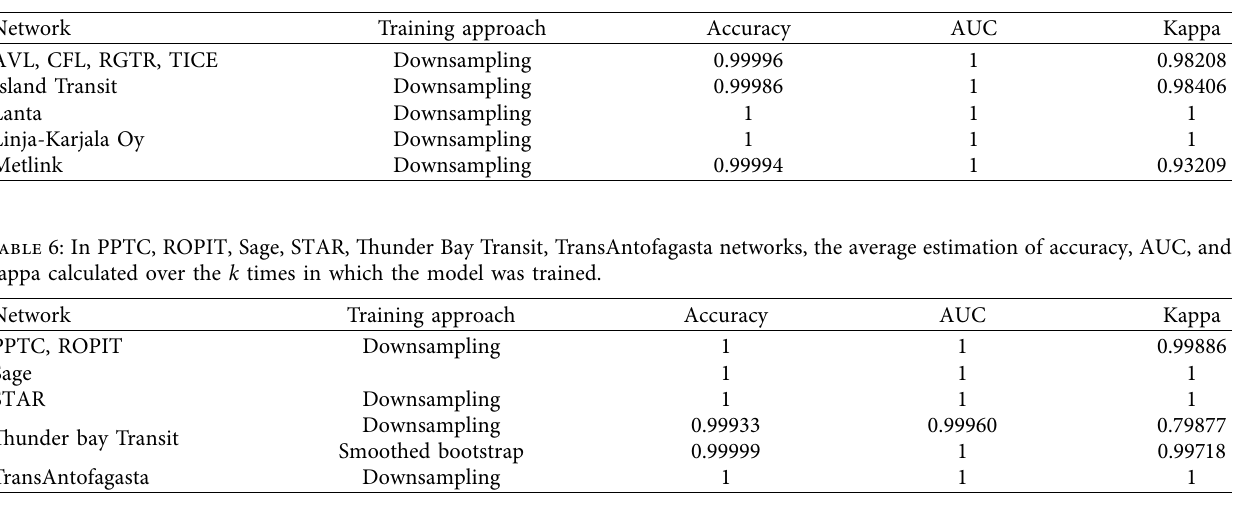
Table 5: In AVL, CFL, RGTR, TICE, Island Transit, Lanta, Linja-Karjala Oy, Metlink networks, the average estimation of accuracy, AUC, and kappa calculated over the k times in which the model was trained.